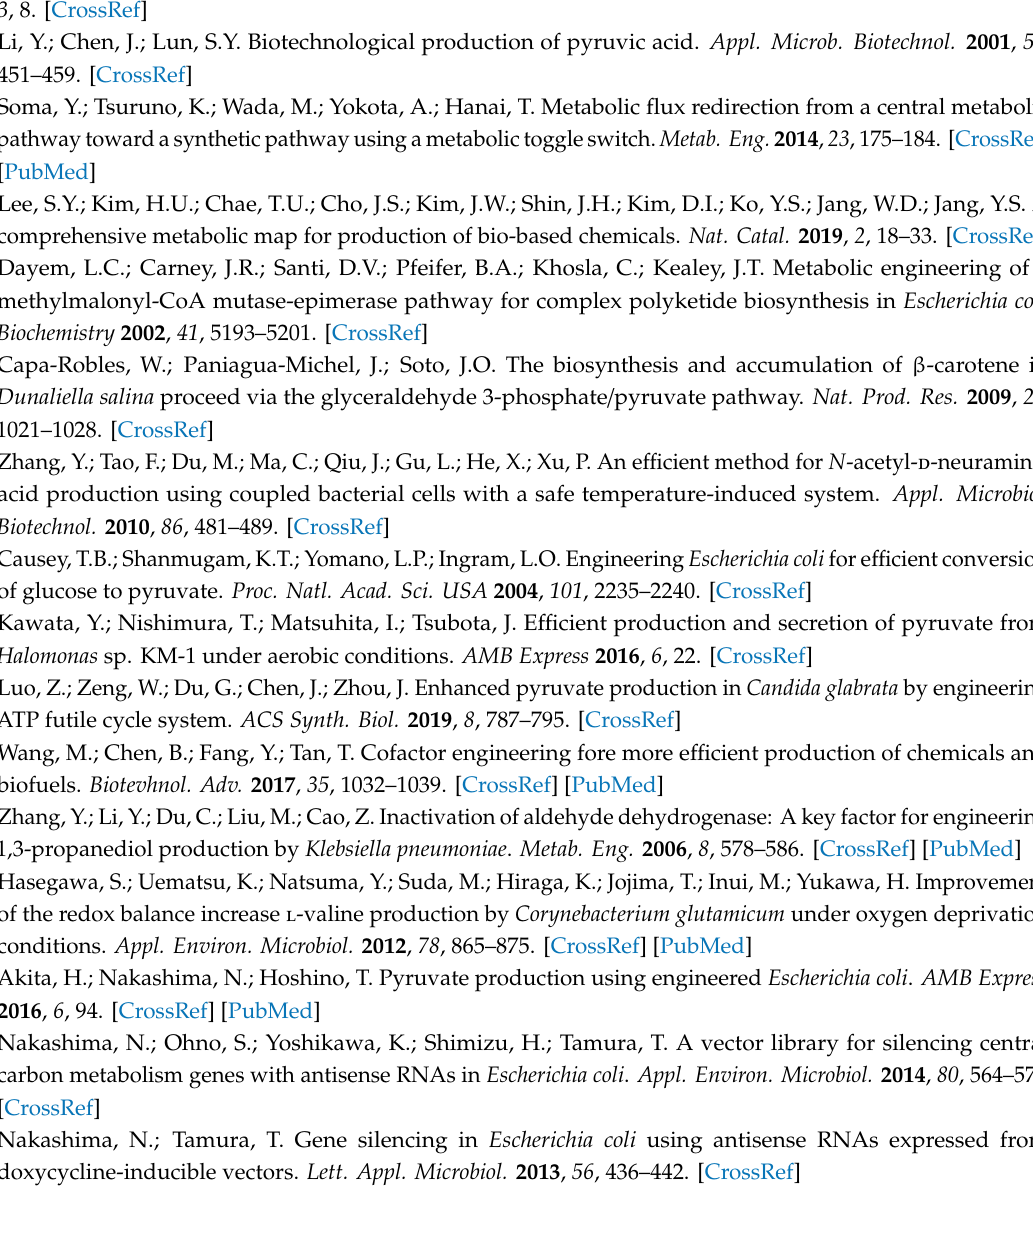
Figure S1: Specific d -lactate production rates after 36 h by LAC strain under the air-regulated (red) and the combined (blue)